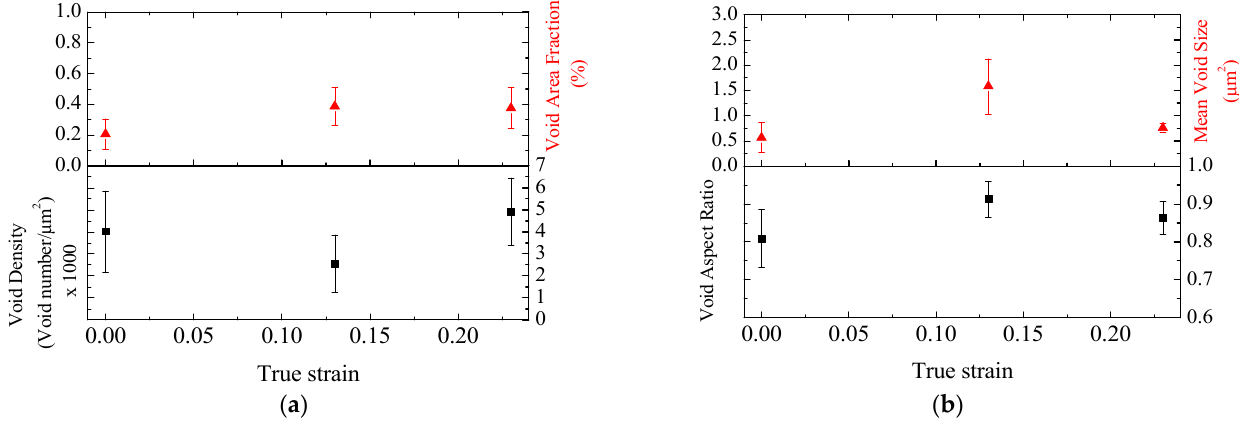
Figure 11. SEM micrographs (1500×) and corresponding binarized image of CR980XG3 TM steel sheet in ( a , b ) as received, ( c , d ) 13% true strain, and ( e , f ) fractured condition.